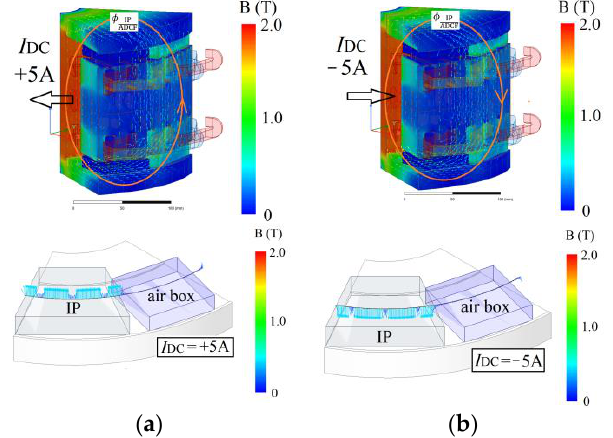
Figure 4. Air-gap magnetic flux density at the different magnetic field distributions I DC = 0, I s = 0 ( a ),